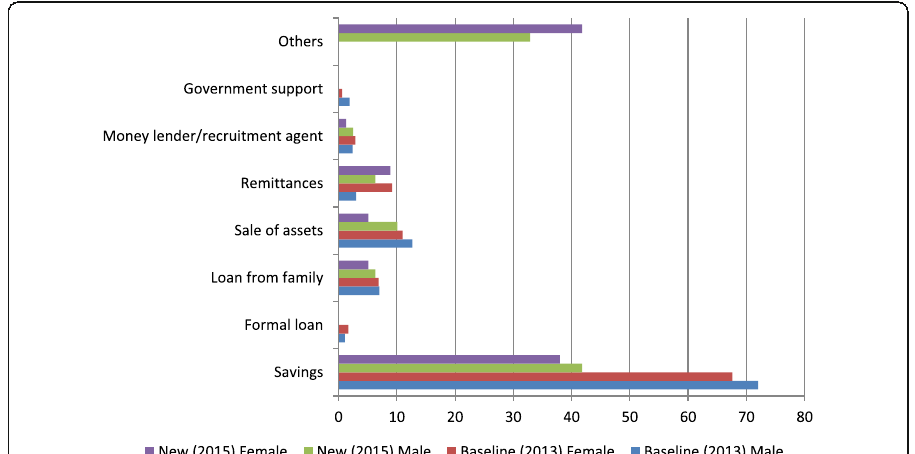
Fig. 1 Financing modes of migration, by type and sex of migrant